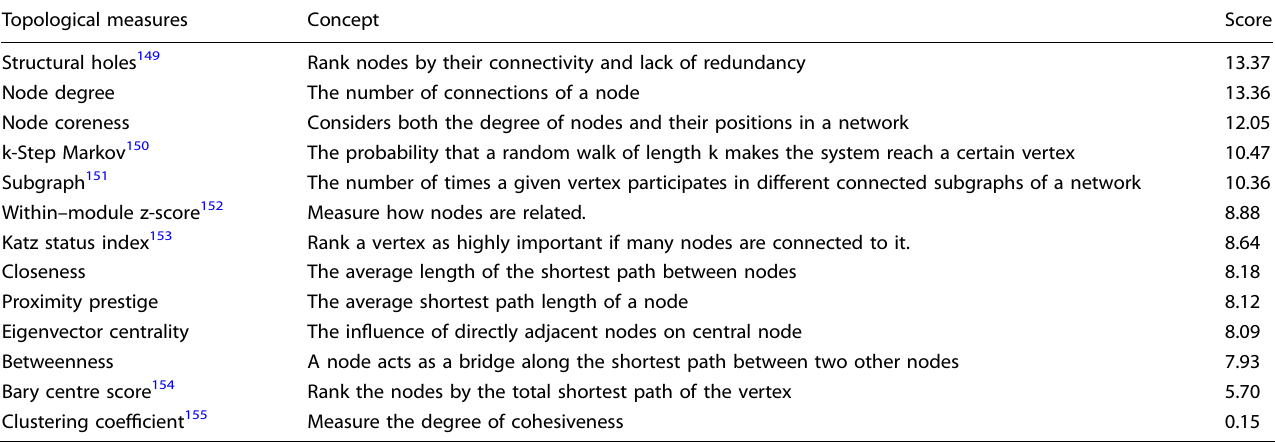
Table 3. Thirteen network topological features for decision tree classi fi cation 147 . The score is a combination of the classi fi cation accuracy and the